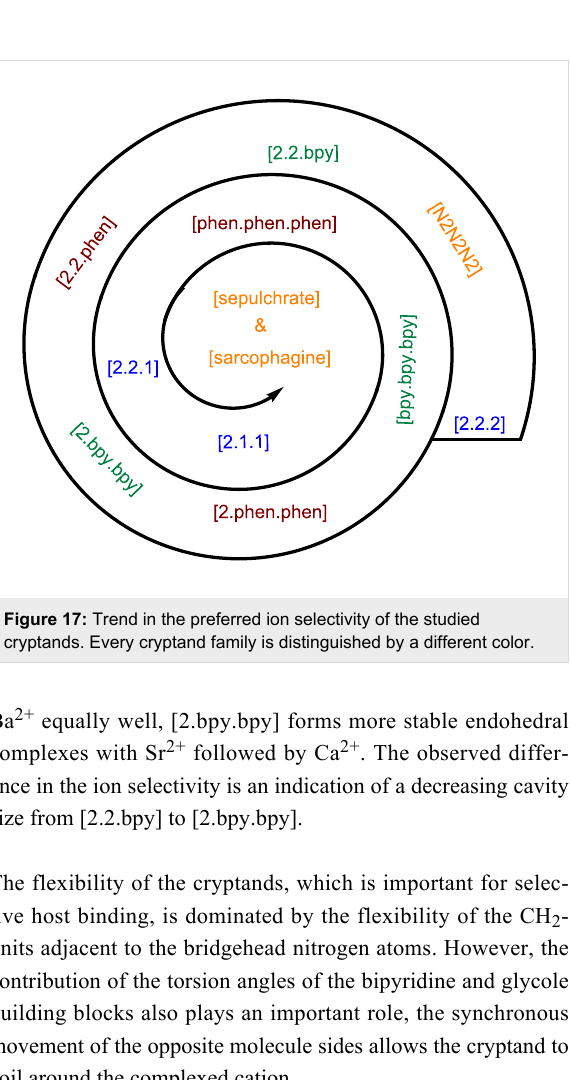
Ba 2+ equally well, [2.bpy.bpy] forms more stable endohedral complexes with Sr 2+ followed by Ca 2+ . The observed differ- ence in the ion selectivity is an indication of a decreasing cavity size from [2.2.bpy] to